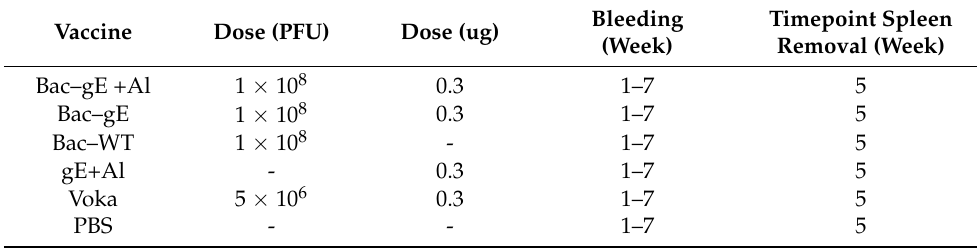
Table 1. Mouse Immunization Study